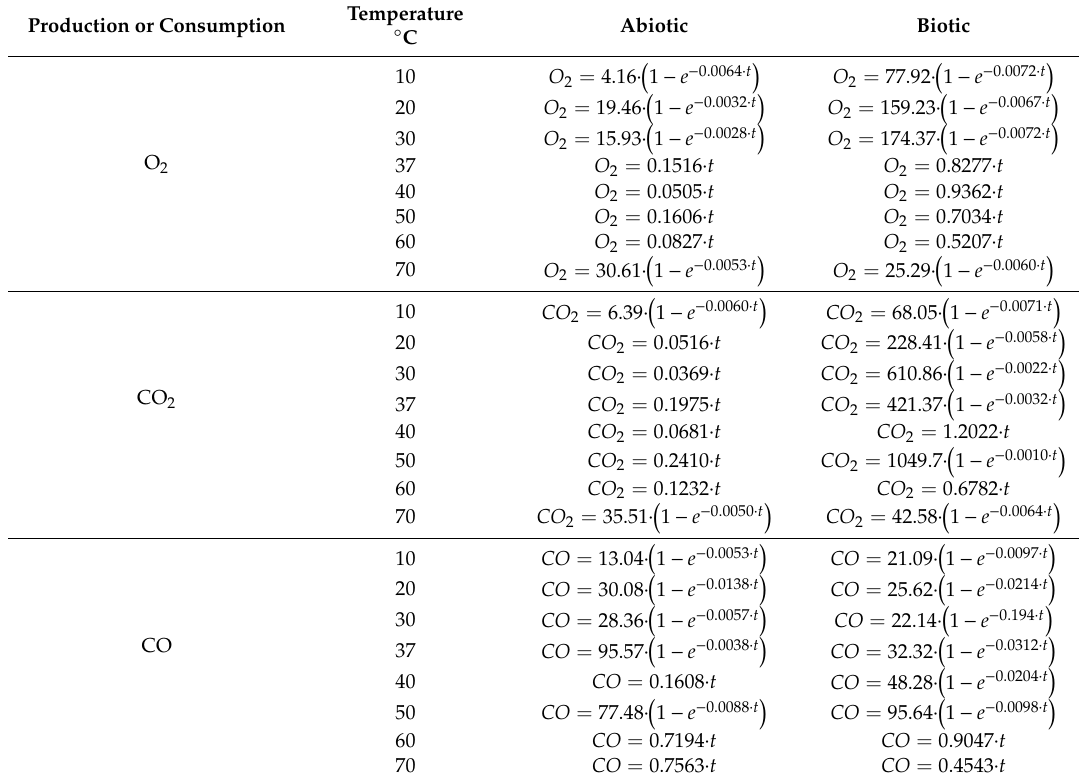
Table A1. Kinetic model of O 2 consumption and CO 2 and CO used for process estimation (based on average results and R 2 ). The kinetic values are shown in Tables S2.1–S2.3 (Supplementary Materials, sheets